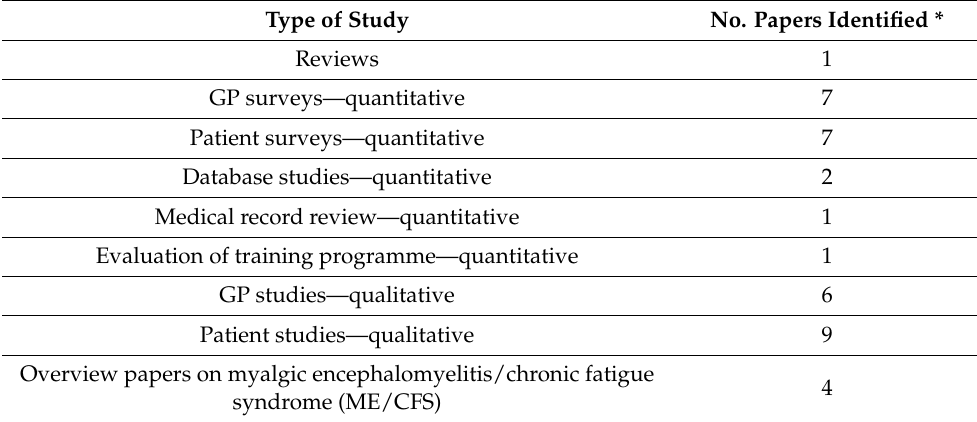
Table 2. Summary of papers